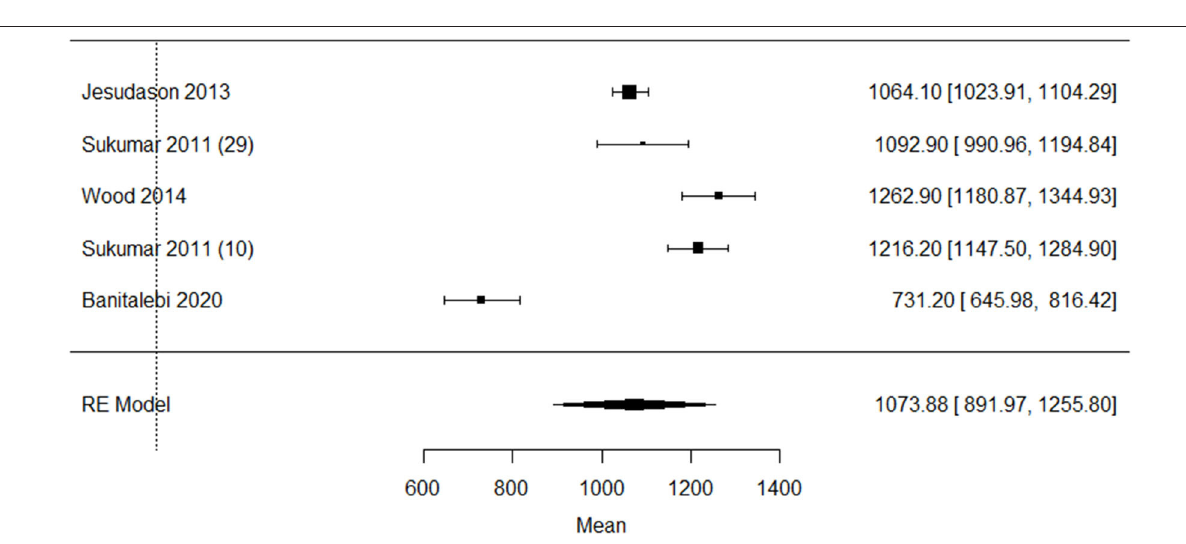
FIGURE 8 | Sensitivity analysis of included studies on calcium intake (milligram/day) in older adults with overweight/obesity mean [95% confidence interval]. RE, Random